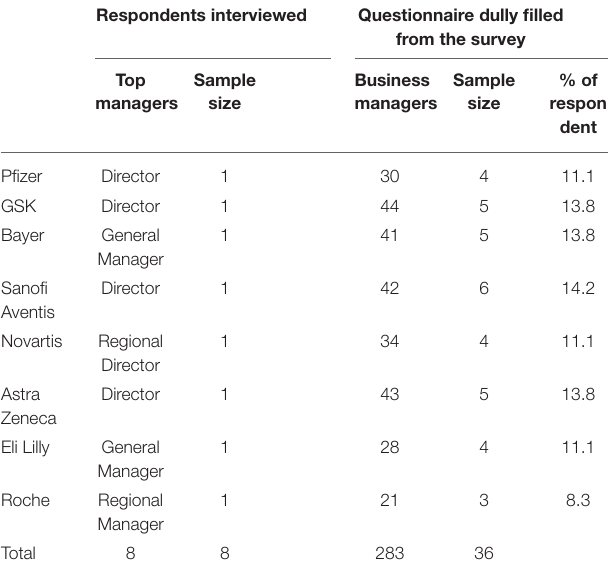
TABLE 2 | Distribution of the respondents from the sample size. Respondents